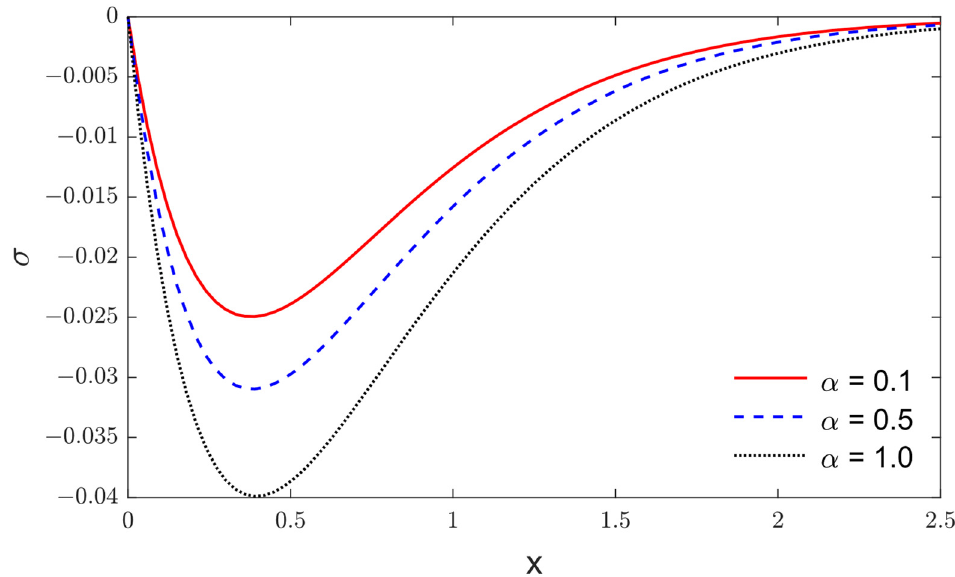
Figure 6. The impact of fractional parameter in the stress variations along the distance x when β = 0.3 and 𝜏 (cid:3042) = 0.05 .